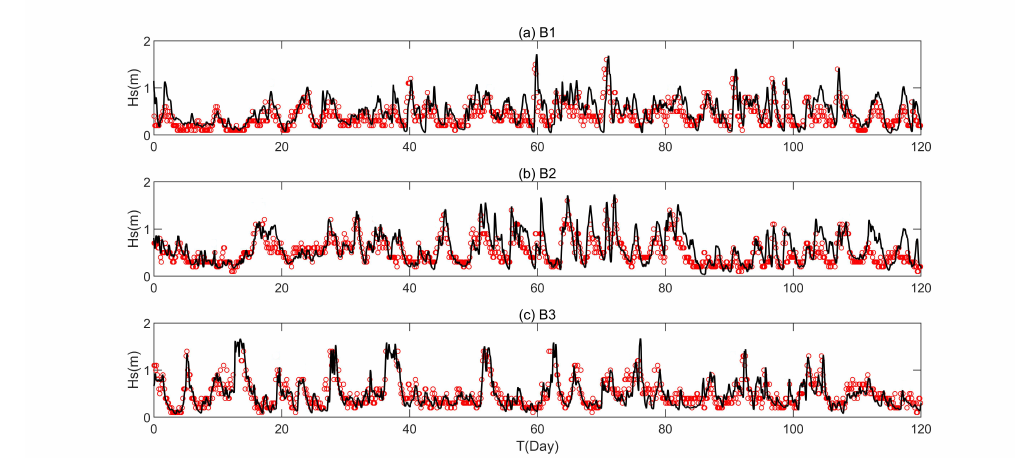
Figure 2. Comparison of hindcast and observed significant wave height (Hs) curves (black line: simulation; red circles: observations; ( a ) B1, ( b ) B2, ( c ) B3 represent buoys 1 to 3 in Figure 1).